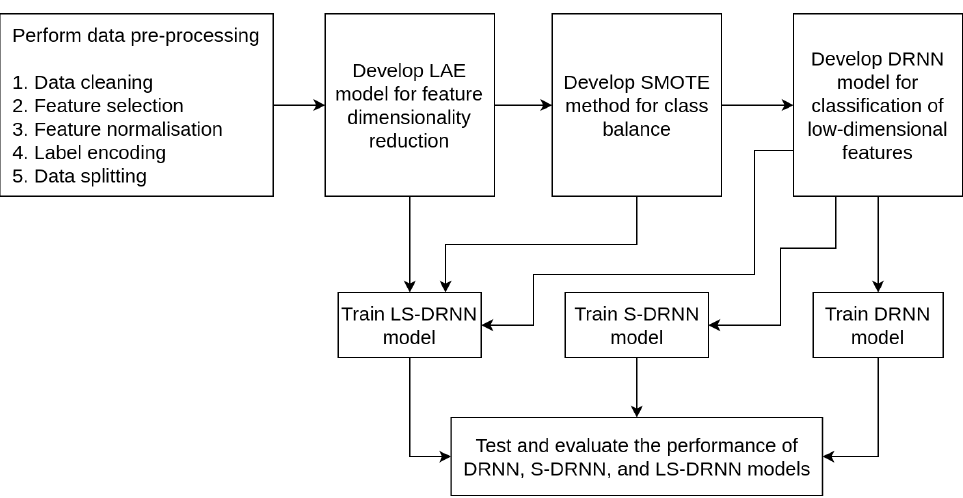
Figure 1. Block diagram showing the proposed